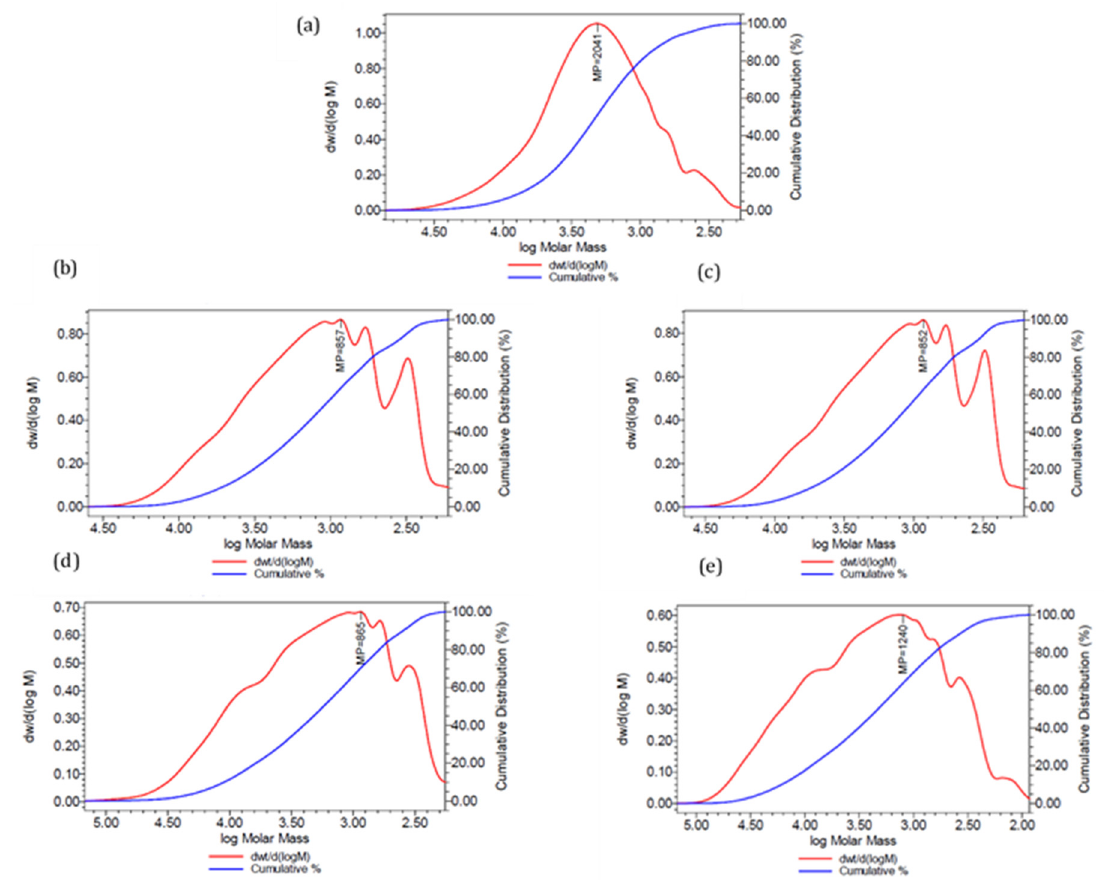
Figure 3. Differential dw/d(logM) and cumulative molar mass distributions of UP2 ( a ), UPD90 ( b ), UPD85 ( c ), UPMD65 ( d ), and DPMD65 ( e ).